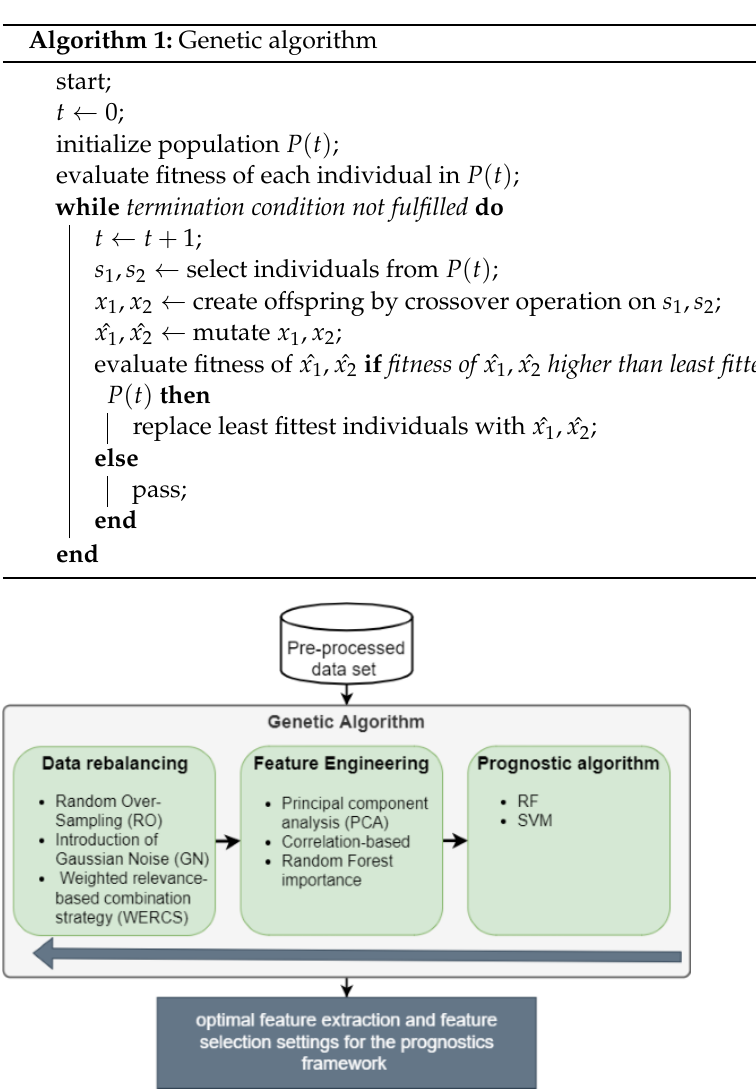
Figure 3. The prognostic steps and methodologies included in the genetic